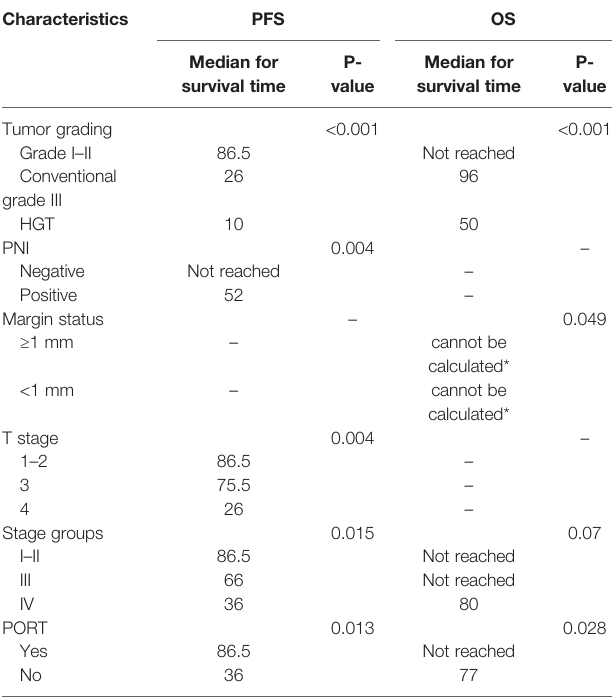
TABLE 5 | Comparison of the median survival time among prognostic predictors on univariate analyses. Characteristics